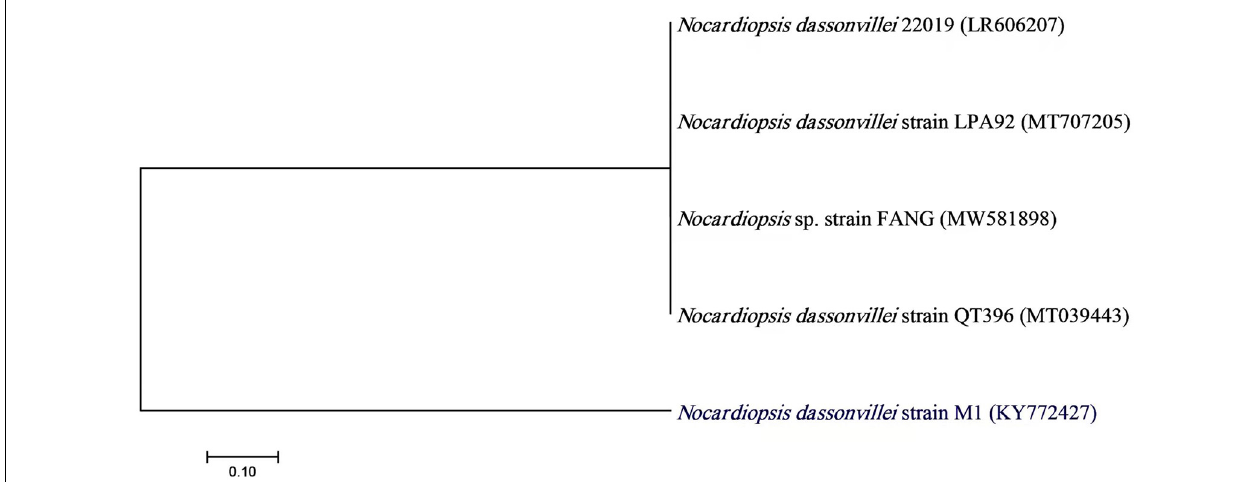
FIGURE 3 | A neighbor-joining tree of Nocardiopsis dassonvillei M1 with its closely related taxa. The bootstrap consensus tree inferred from 1000 replicates represents the evolutionary history of the taxa analyzed. The scale bar indicates 0.10 substitutions per nucleotide